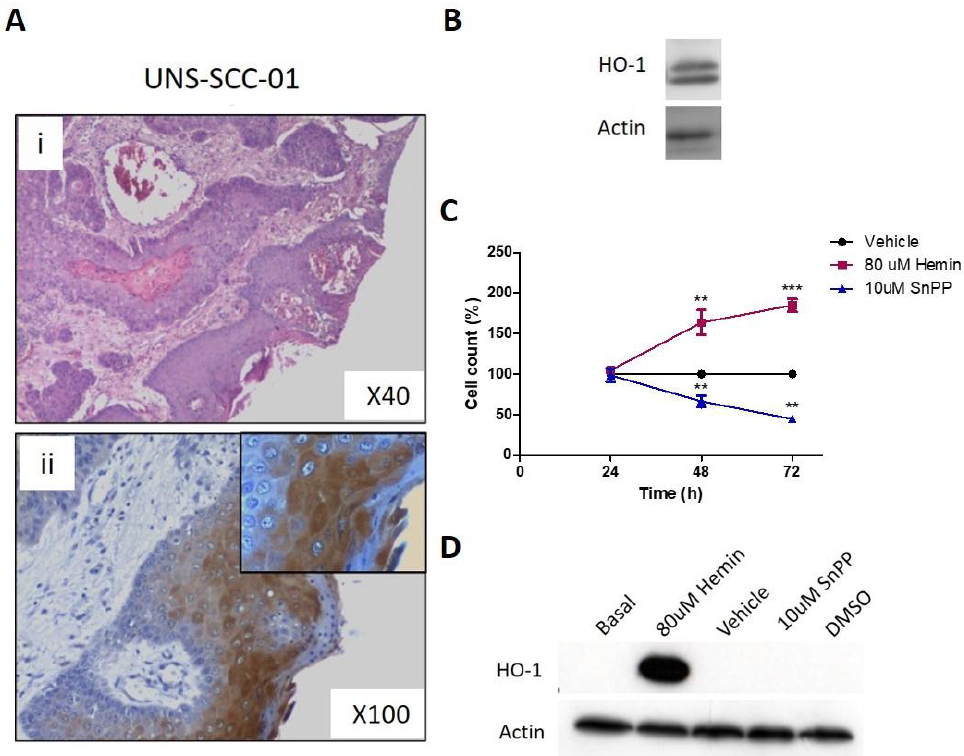
Figure 7. Expression and pharmacological modulation of HO-1 in human mixed primary cell culture of squamous cell carcinoma. ( A ) Representative images of hematoxylin eosin staining (i) and HO-1 staining (ii) by immunohistochemistry a tumor biopsy of human SCC. ( B ) HO-1 expression of sample shown in ( A ) by immunoblot. ( C ) Cell viability of the human mixed primary cell culture after treatment with 80 uM hemin or 10 uM SnPP or their respective vehicles at 24 to 72 h. ( D ) HO-1 protein expression evaluated after treatment with 80 uM hemin or 10 uM SnPP or their respective vehicles at 48 h. The results are expressed as cell viability percentage = (selected time group × 100/time 0 h group), with a selected time from 24 h to 96 h. ** p < 0.01 and *** p < 0.001 with respect to the vehicle.